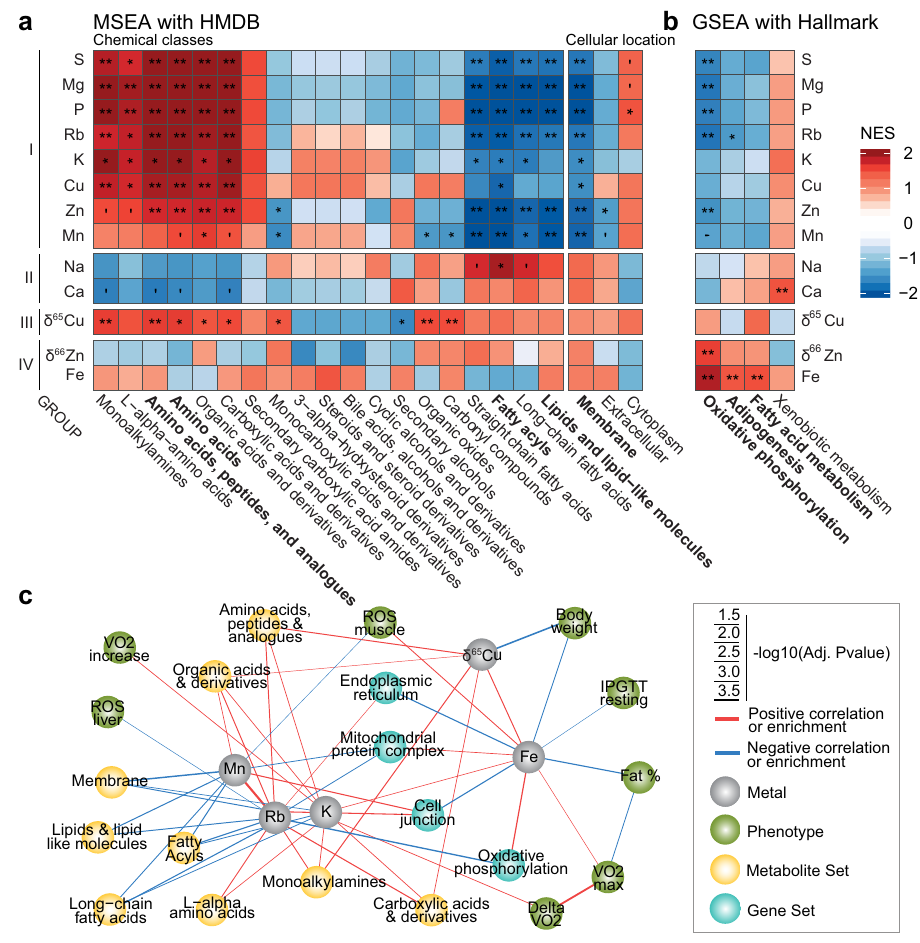
Fig. 4 Enrichment analyses in the liver metabolome and proteome converge towards common associations between ions and mitochondrial and fatty acid metabolism. a , b Metabolites and proteins were sorted on their correlation with individual metals in the liver, then metabolite or gene -set enrichment analyses (MSEA, ( a ), GSEA, ( b )) were performed. For each metal, the top three gene or metabolite sets are pictured. FDR-corrected p -values.**Adj. P < 0.01, *Adj. P < 0.05, ‘ Adj. P < 0.1 ( c ) Network representation, combining the most signi fi cant correlations between metals, between metals and phenotypes (Spearman Rho and limma test, both), as well as the metabolite and gene set enrichment analyses. All tests were two-sided when applicable and p -values are FDR corrected. To limit the number of nodes, only nodes with very signi fi cant associations are pictured (Adj. P < 0.01), but all edges with Adj. P < 0.05 are drawn. Source data are provided as a Source Data fi